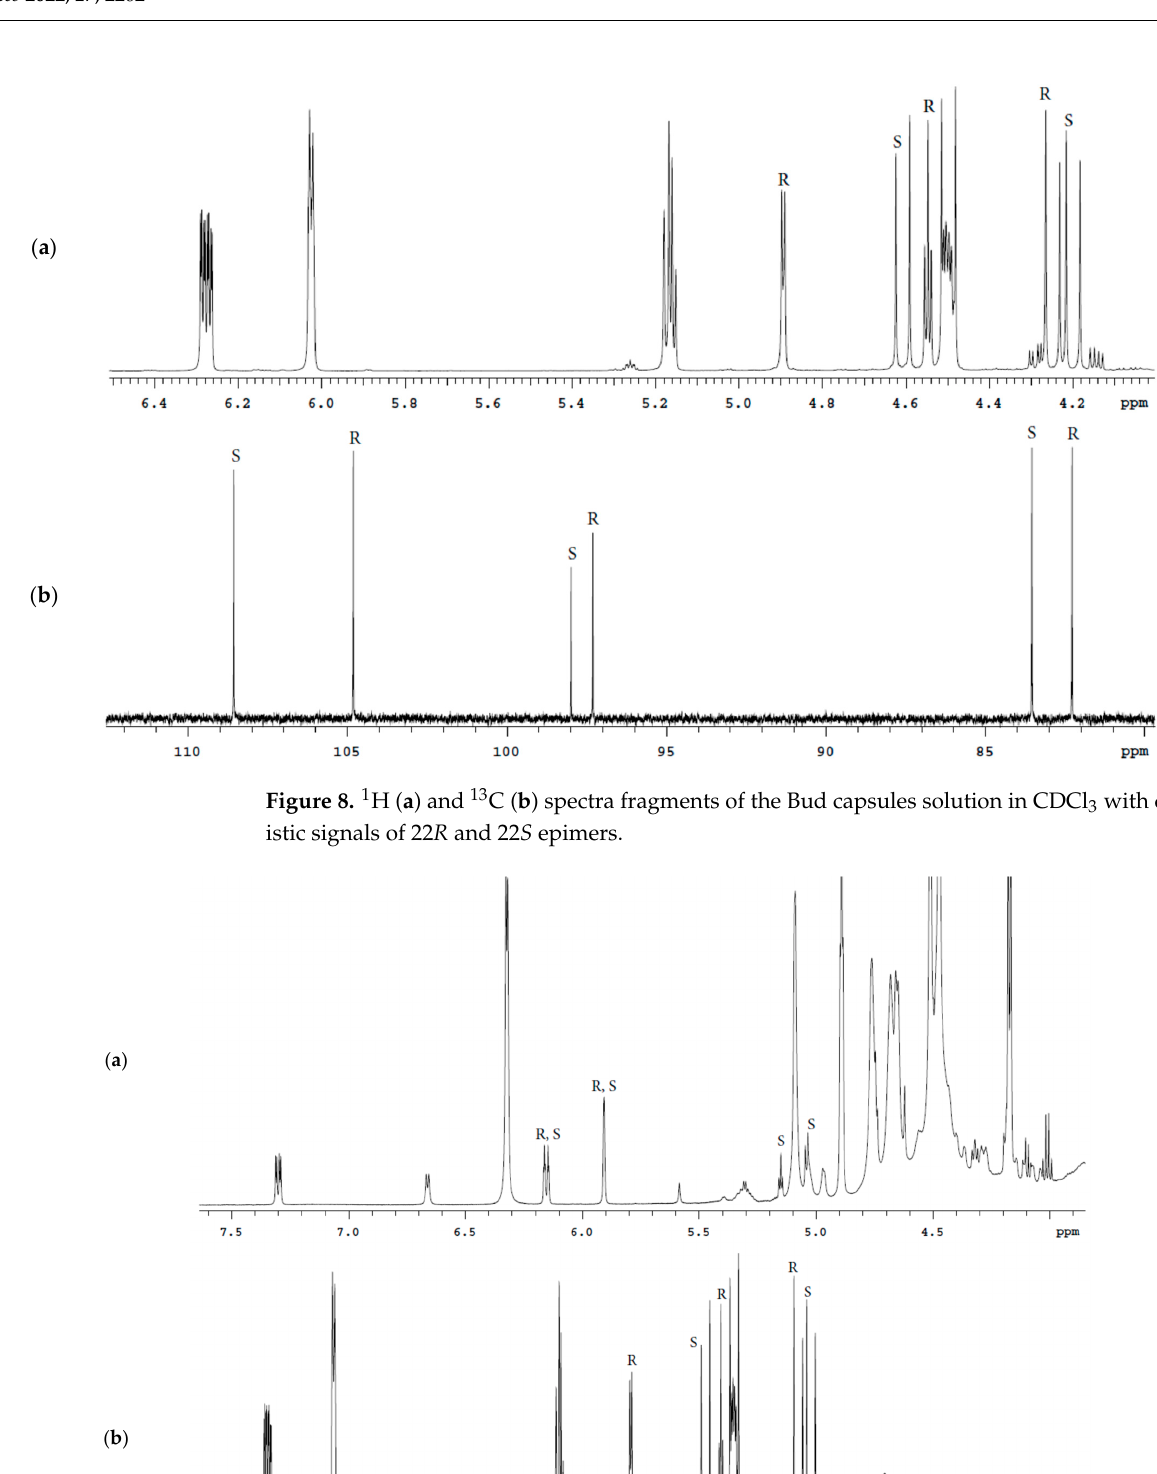
Figure 7. 1 H ( a ) and 13 C ( b ) spectra fragments of the Bud nasal spray solution in CDCl 3 with char- acteristic signals of 22 R and 22 S epimers.